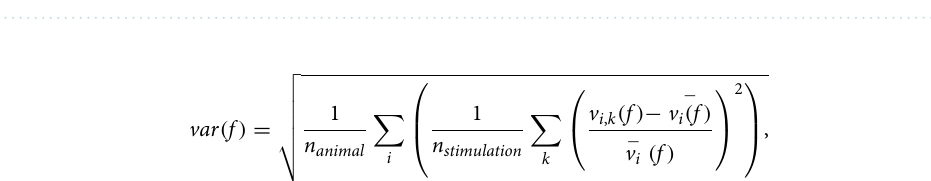
Figure 4. The variability of the six different threshold estimation methods. The variability is computed according to Eq. (2) for the nine different threshold estimations